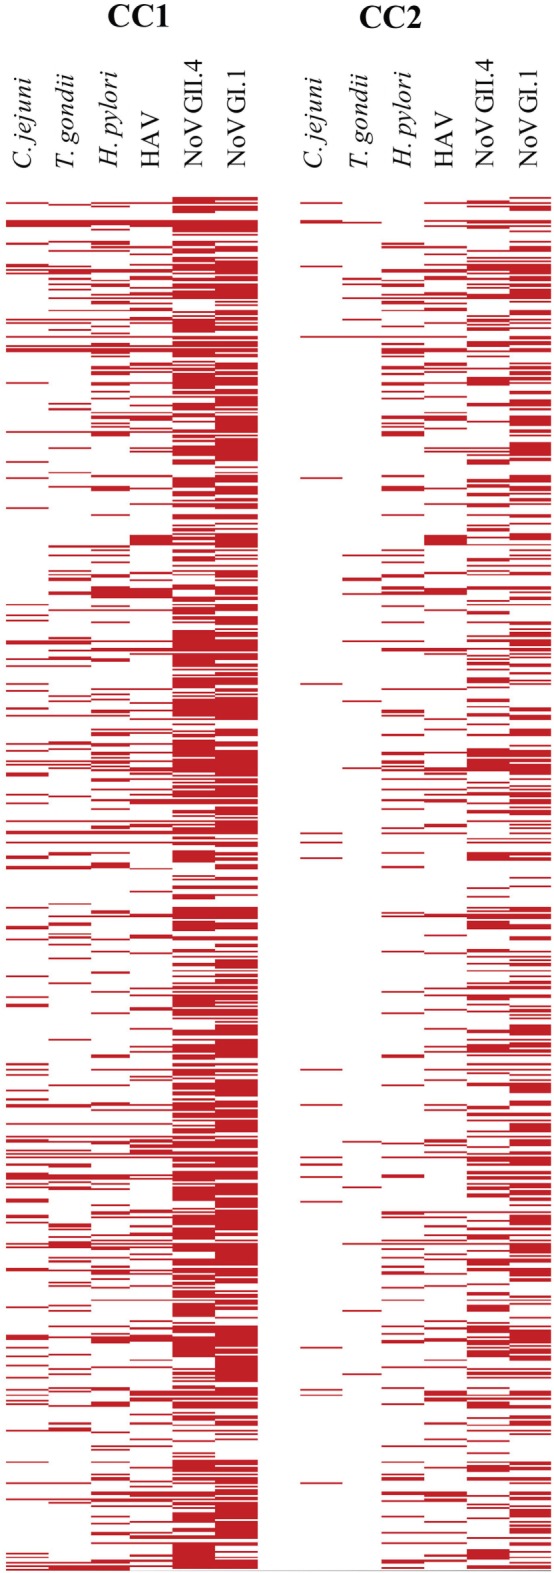
Visualization of cutoff point ratios. The left panel shows the positive samples based on cutoff point criteria 1 (CC1) [150 median fluorescence intensity (MFI)], and the right panel indicates positive samples based on cutoff point criteria 2 (CC2) (505 MFI). Ratios over 1 (MFI ≥ cutoff point) are red in the plots. MFIs below cutoff point are white.